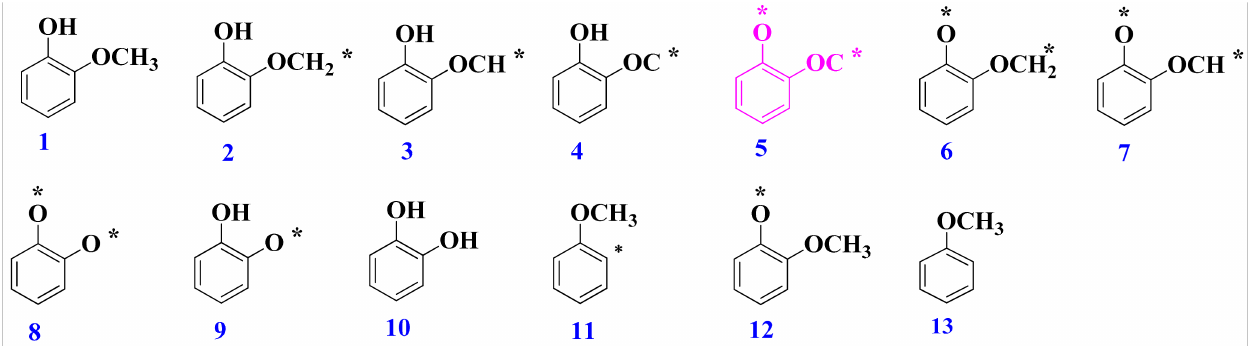
Figure 1. Structures of compounds (reactant, intermediates, and products) under study. An asterisk indicates bound (di-)radical site(s) to the metal surface. Structure 5 is not a stable structure on the surface, as it